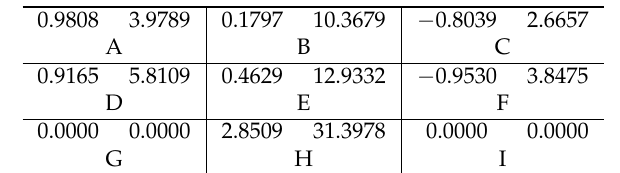
Table 4. Velocity components for loose initial packing density presented for nine zones from A–I (zeros for G and I). Each quadrant presents horizontal (Vx on the left) and vertical (Vy on the right) components only. Vx and Vy values are given in